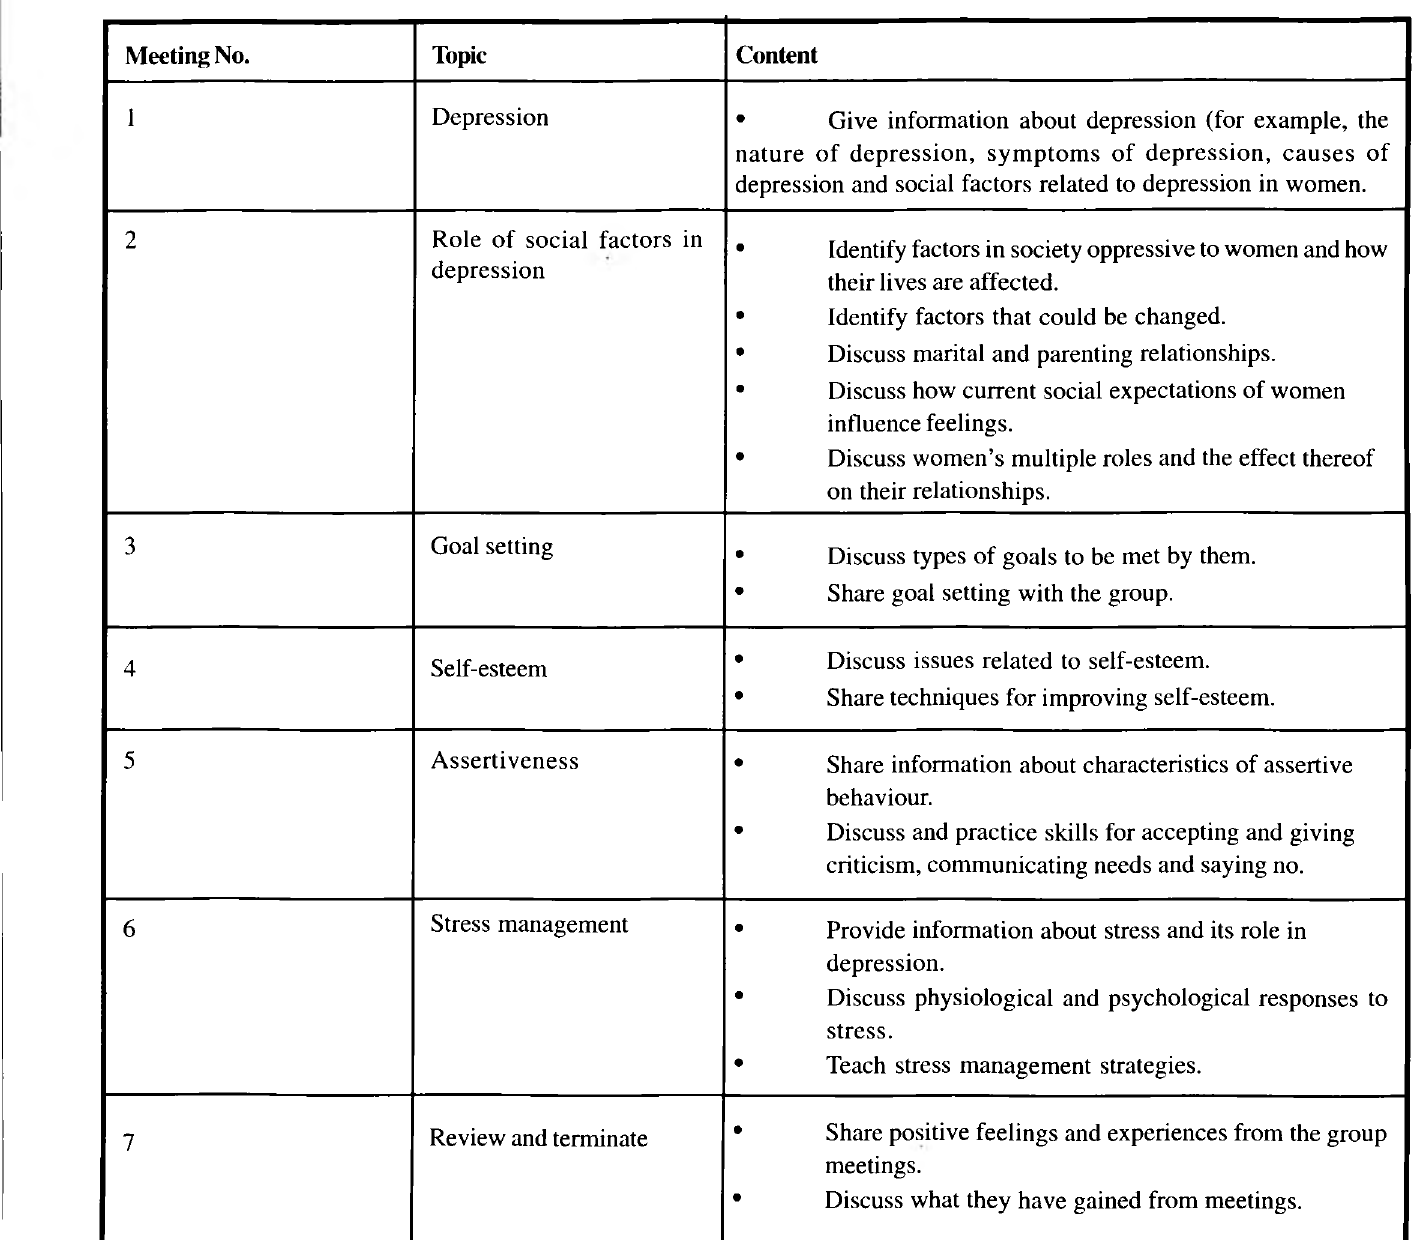
Table 1: Content and sequence of the psycho-educational group meeting Meeting